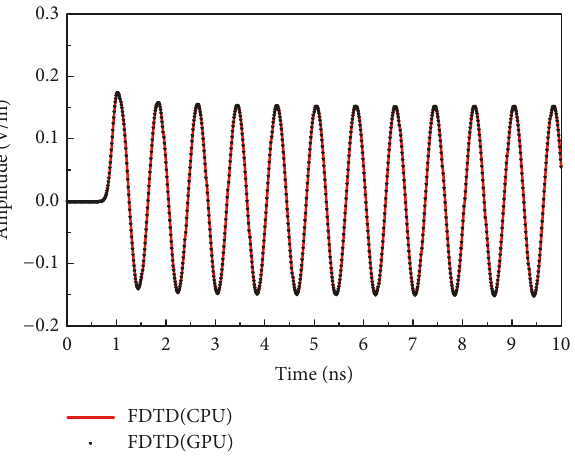
Figure 8: Field value of the observation point with two